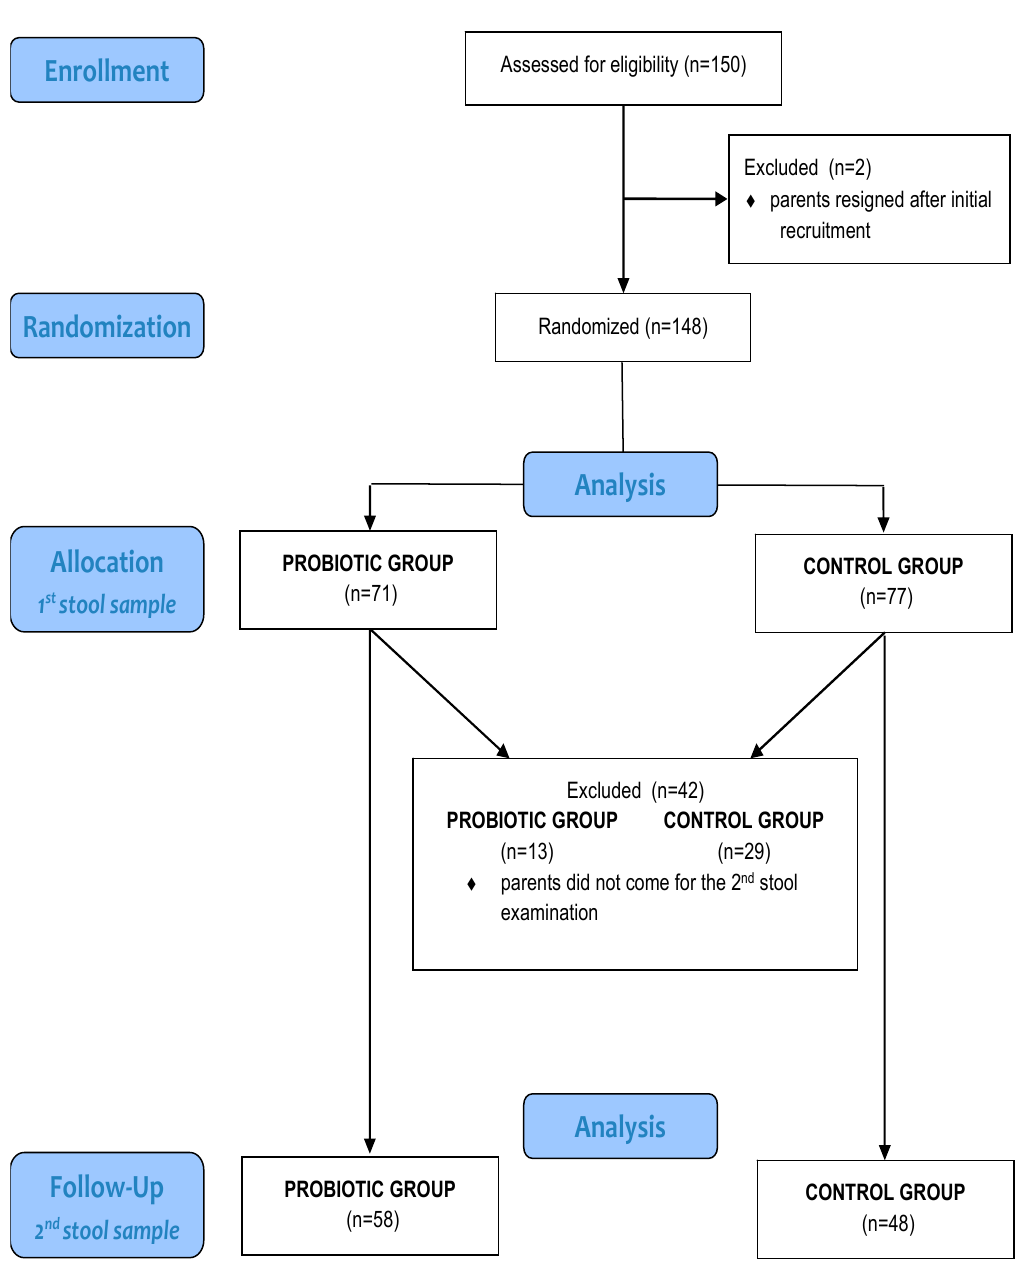
Figure 1. Participant flow